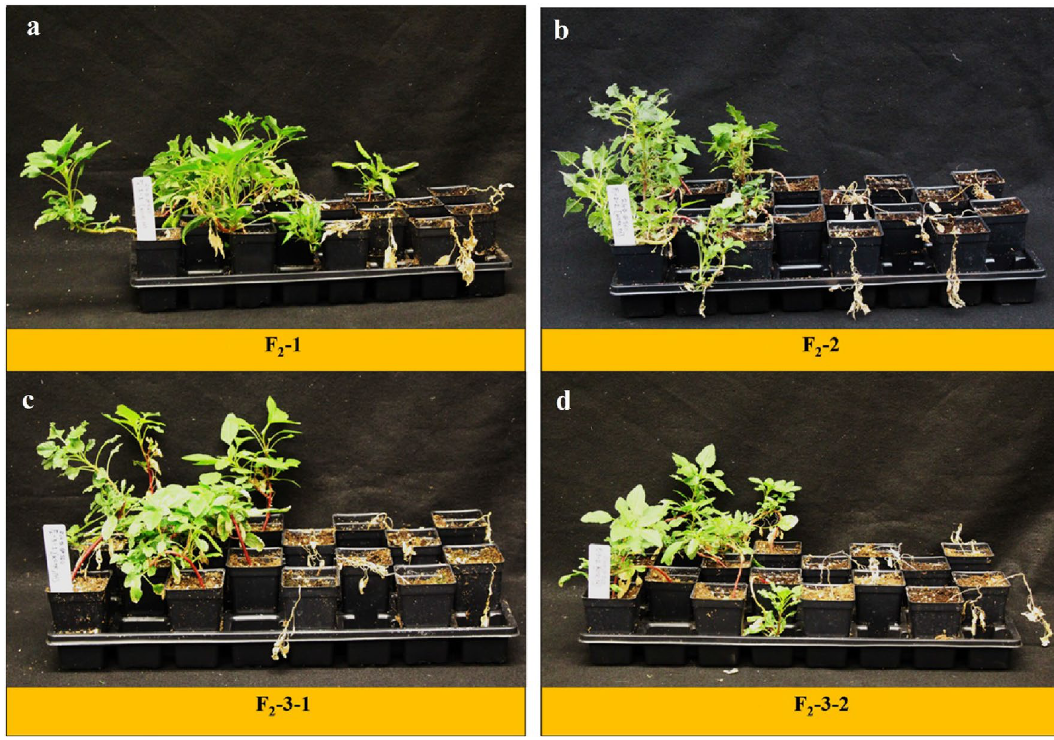
Figure 4. Diverse phenotype of F 2 progenies from family ( a ) F 2 -1, ( b ) F 2 -2, ( c ) F2-3-1, and ( d ) F 2 -3-2 in response to 2,4-D at 560 g ae ha −1 (field recommended dose) at 4 weeks after